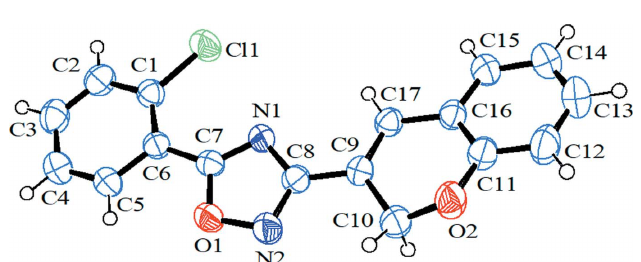
Figure 1 The molecular structure of the title compound, with displacement ellipsoids drawn at the 50% probability level.